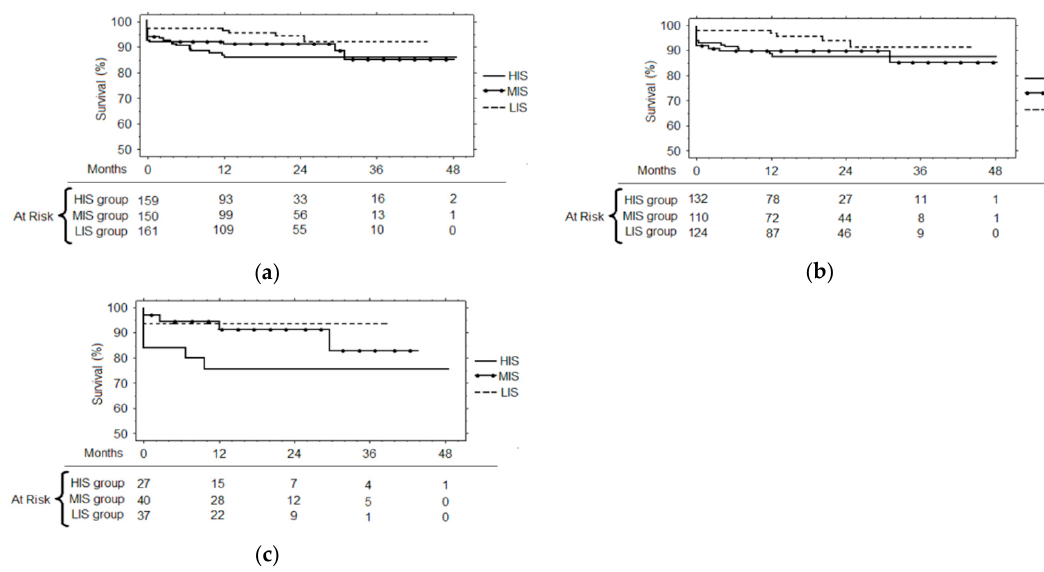
Figure 2. ( a ) The 48-months survival for patients of the LIS, MIS and HIS group. ( b ) Subgroup of patients undergone coronary artery bypass grafting (CABG): The 48-months survival for patients of the LIS, MIS and HIS group. ( c ) The subgroup of patients undergone cardiac surgery other than CABG: The 48-months survival for patients of the LIS, MIS and HIS group. Antibiotics 2019 , 8 , 176